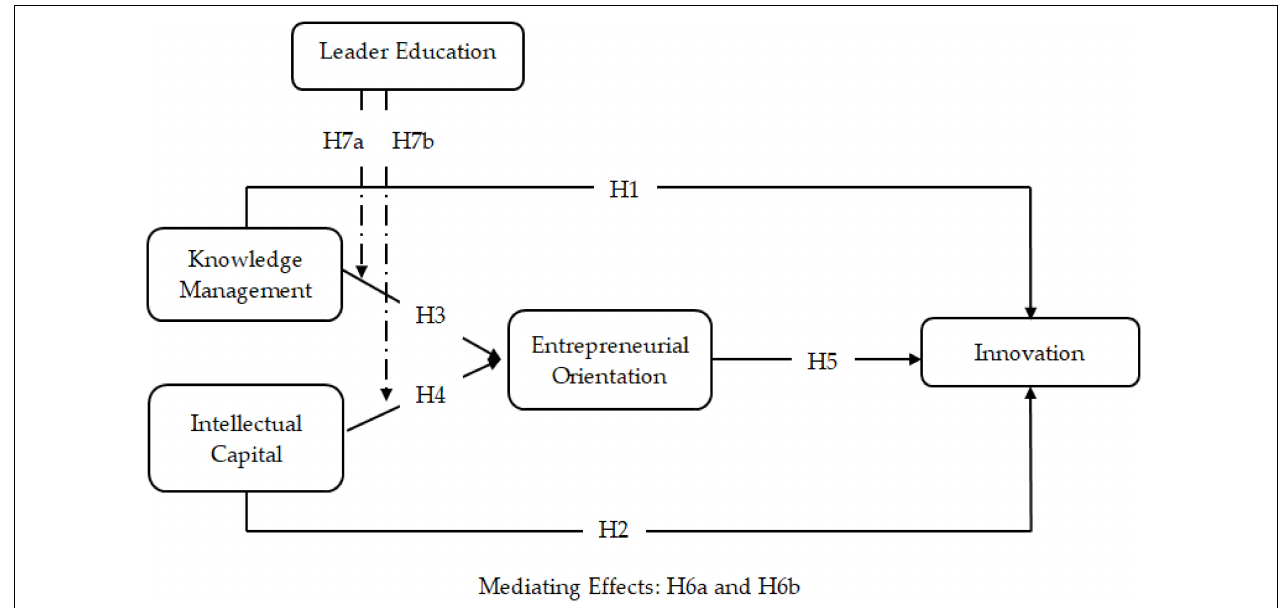
FIGURE 1 | Conceptual